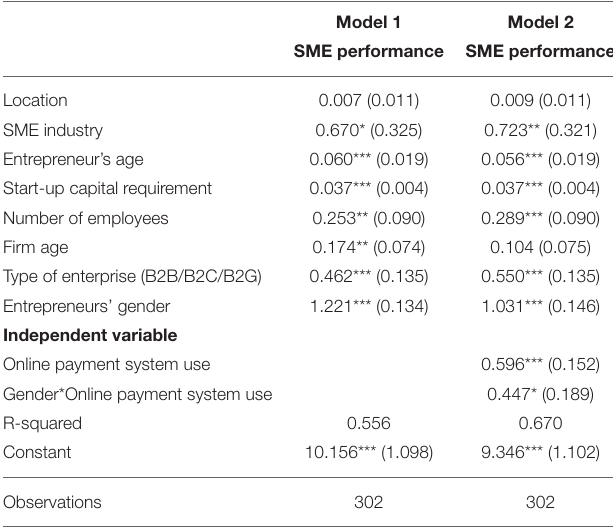
TABLE 6 | Regression outputs—the impact of the online payment system on SME